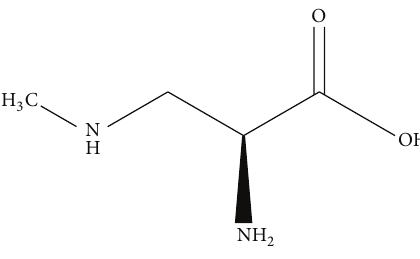
Figure 1: L-BMAA chemical structure.